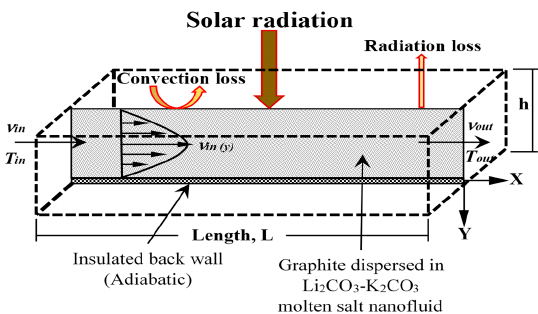
Figure 1. Computational model setup for the direct absorption collector (DAC) receiver.